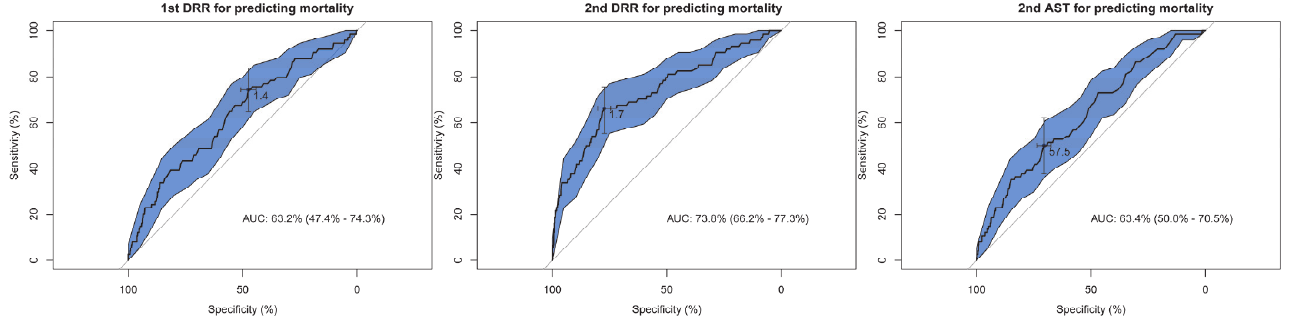
Figure 2. The receiver operating characteristic curves and the area under the curve (AUCROC) of the 1st and 2nd DRR to predict the mortality of the adult trauma patients in the intensive care unit.